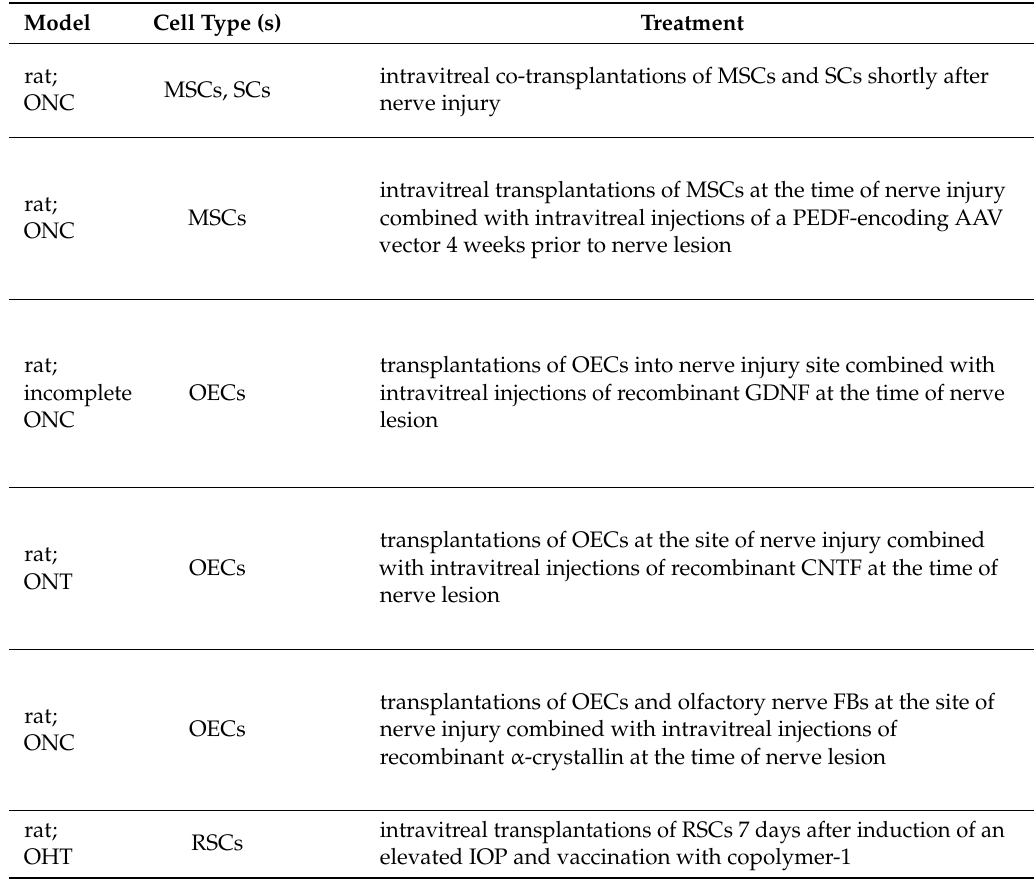
Table 2. Boosting RGC survival with combinatorial neuroprotective